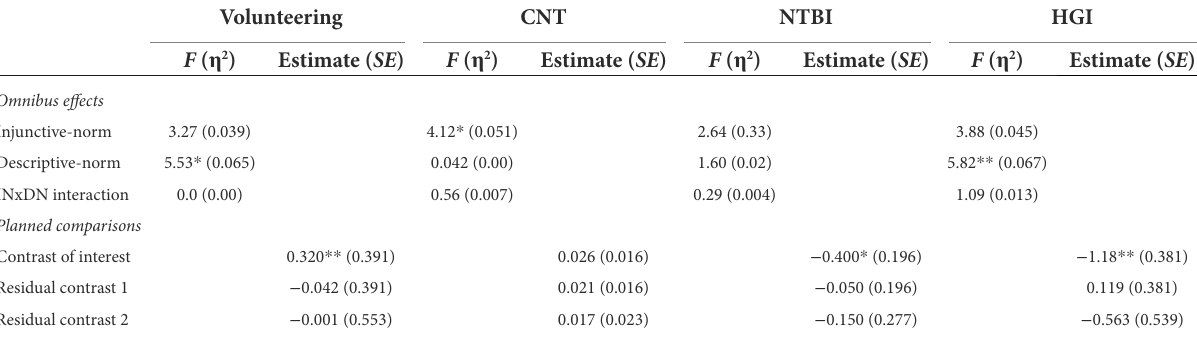
TABLE 2 Omnibus effects and planned comparisons for 2 × 2 ANOVAs on the four dependent